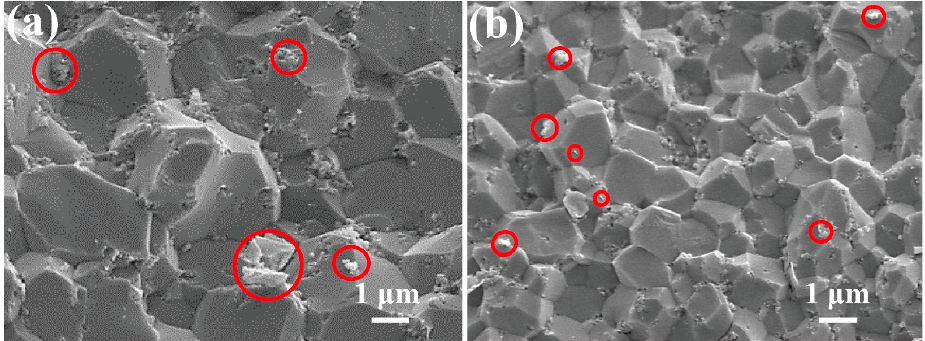
Figure 1. SEM images of ( a ) Al 2 O 3 -G-O, and ( b ) Al 2 O 3 -G-M (The red circle represents graphene).